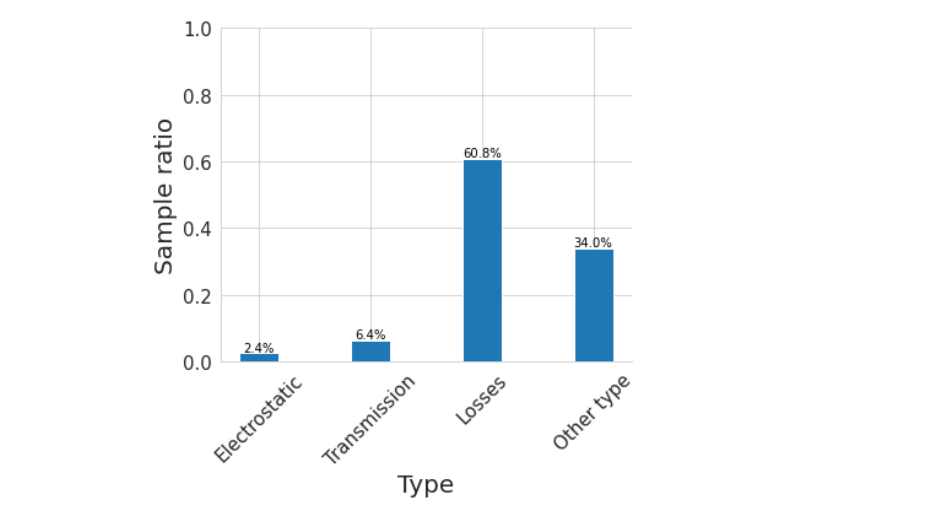
Figure 3. Distribution of the interlock events by type. “Other Types” denotes all interlock causes that are not prevalent enough to have a separate category. Please note that an interlock may be labeled as more than one type.